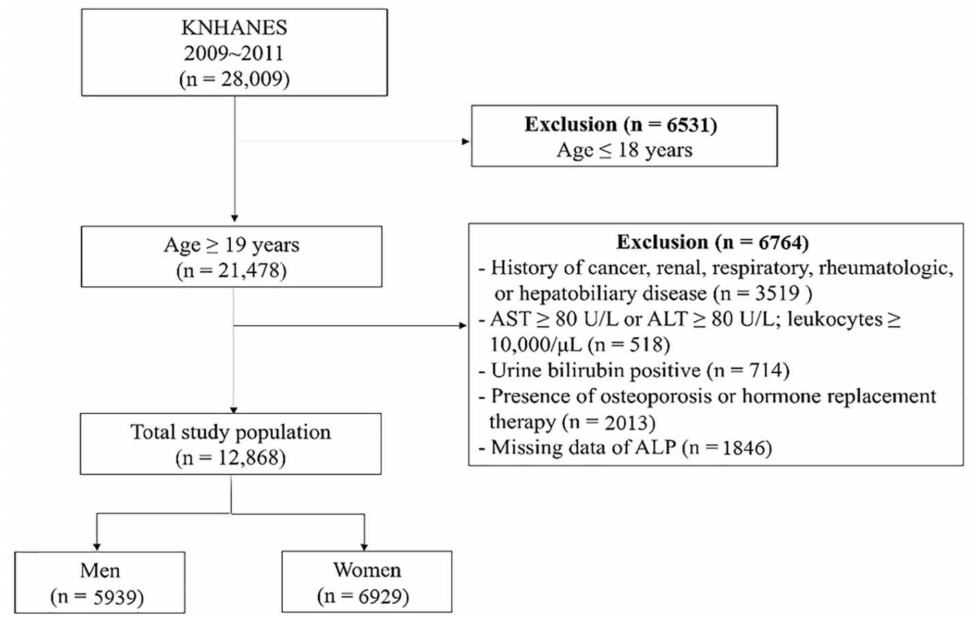
Figure 1. Flowchart of the study population